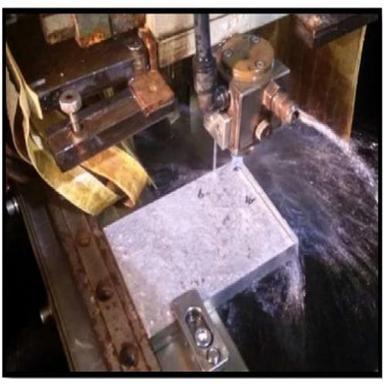
Process of dimensioning using WCEDM.